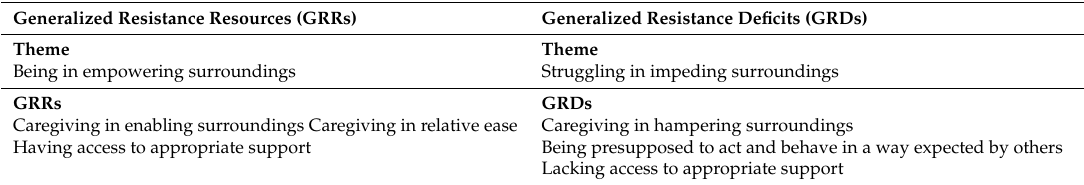
Table 3. Environmental and contextual Generalized Resistance Resources and Deficits among informal Swedish